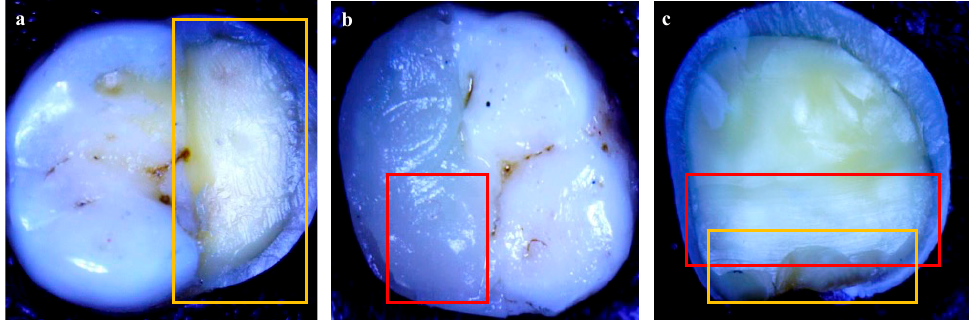
Figure 4. Fracture patterns under stereomicroscopes: ( a ) Adhesive, indicated by yellow square; ( b ) Cohesive, indicated by red square; ( c ) Mixed.